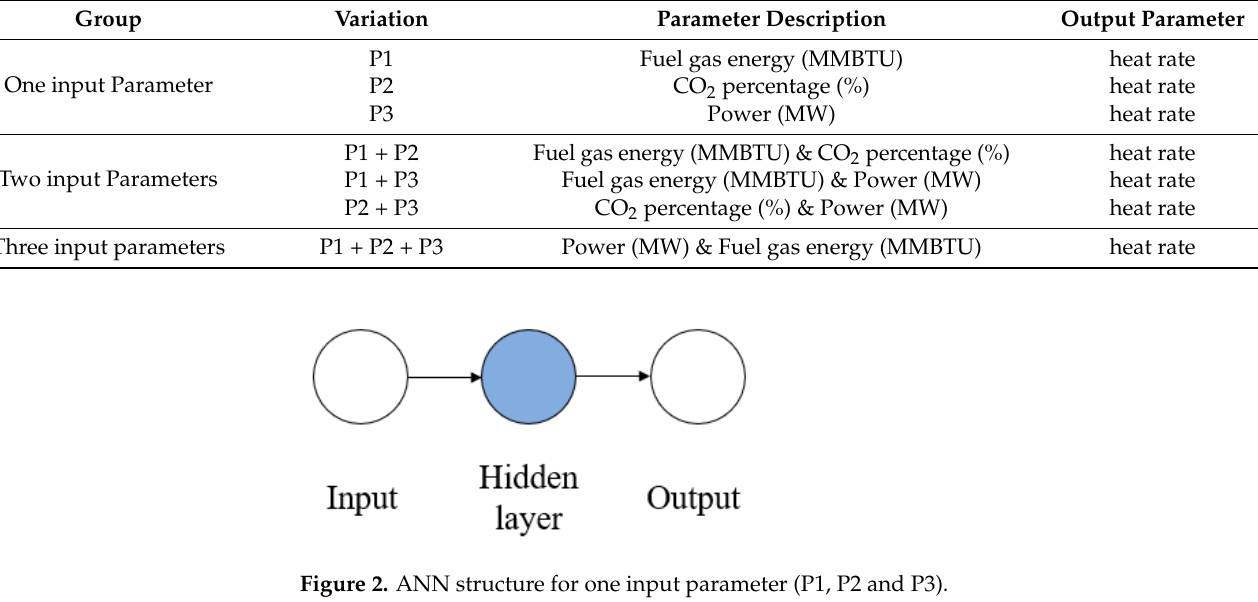
Table 2. Input and output parameter for the artificial neural network (ANN) model.